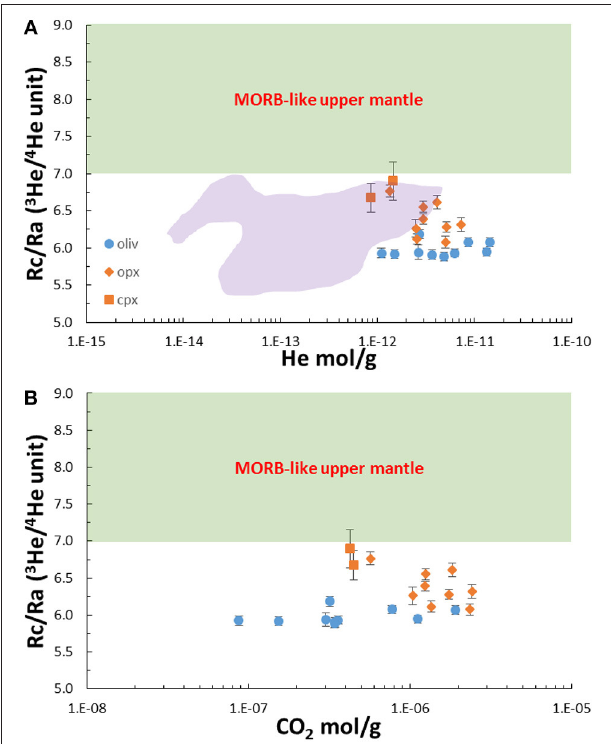
FIGURE 6 | Concentrations of He and CO 2 vs. 3 He/ 4 He corrected for air contamination (Rc/Ra values). The green bar indicates the range of 3 He/ 4 He ratios for a MORB-like mantle (8 ± 1 Ra; Graham,